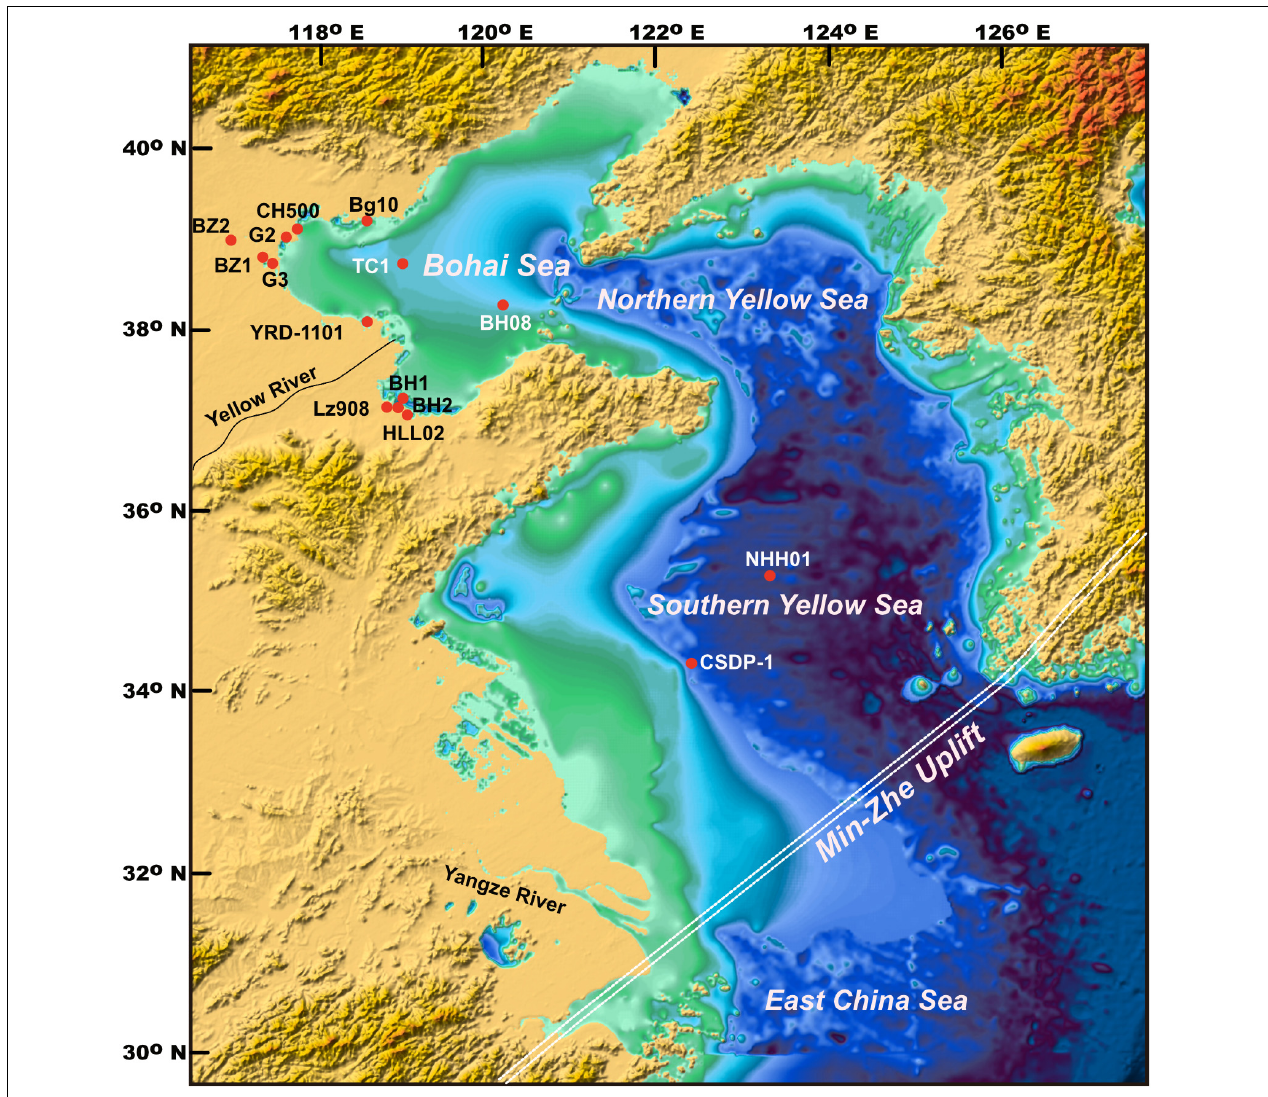
FIGURE 1 | Location of the Bohai Sea, Yellow Sea, and of core NHH01 and other cores mentioned in the